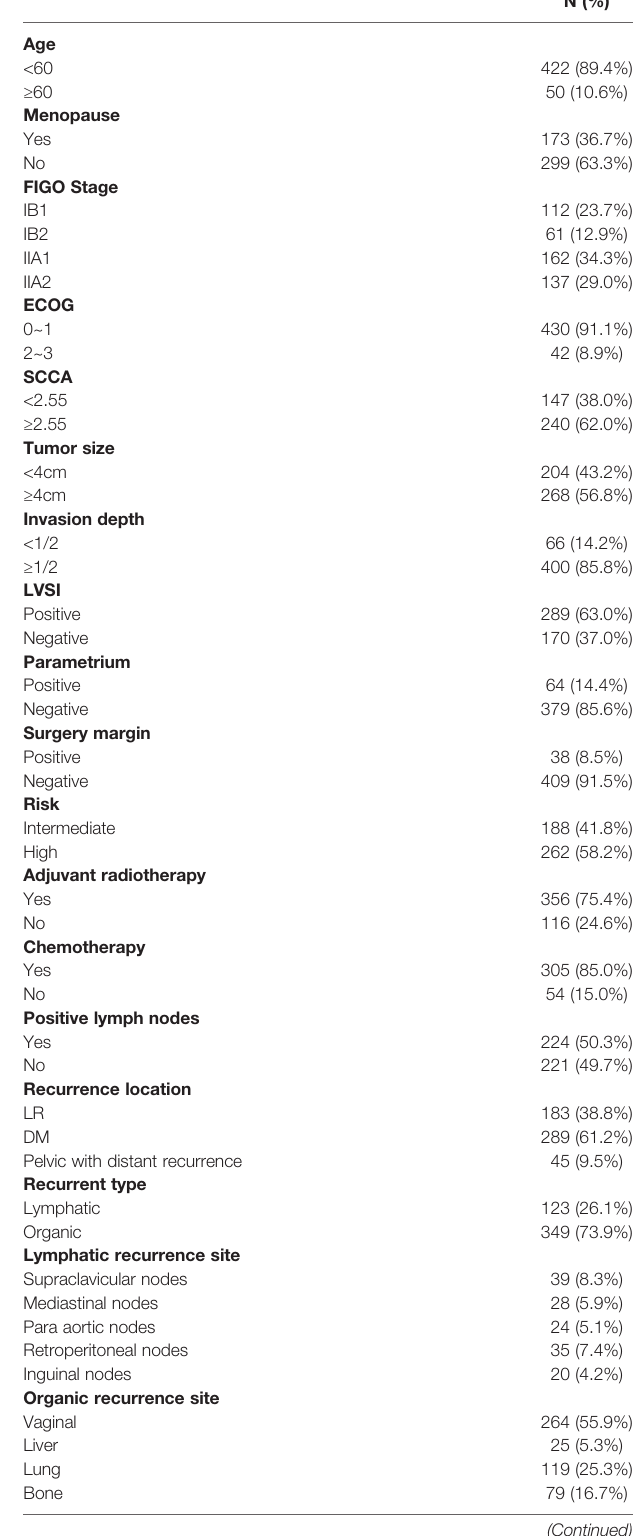
TABLE 1 | Baseline